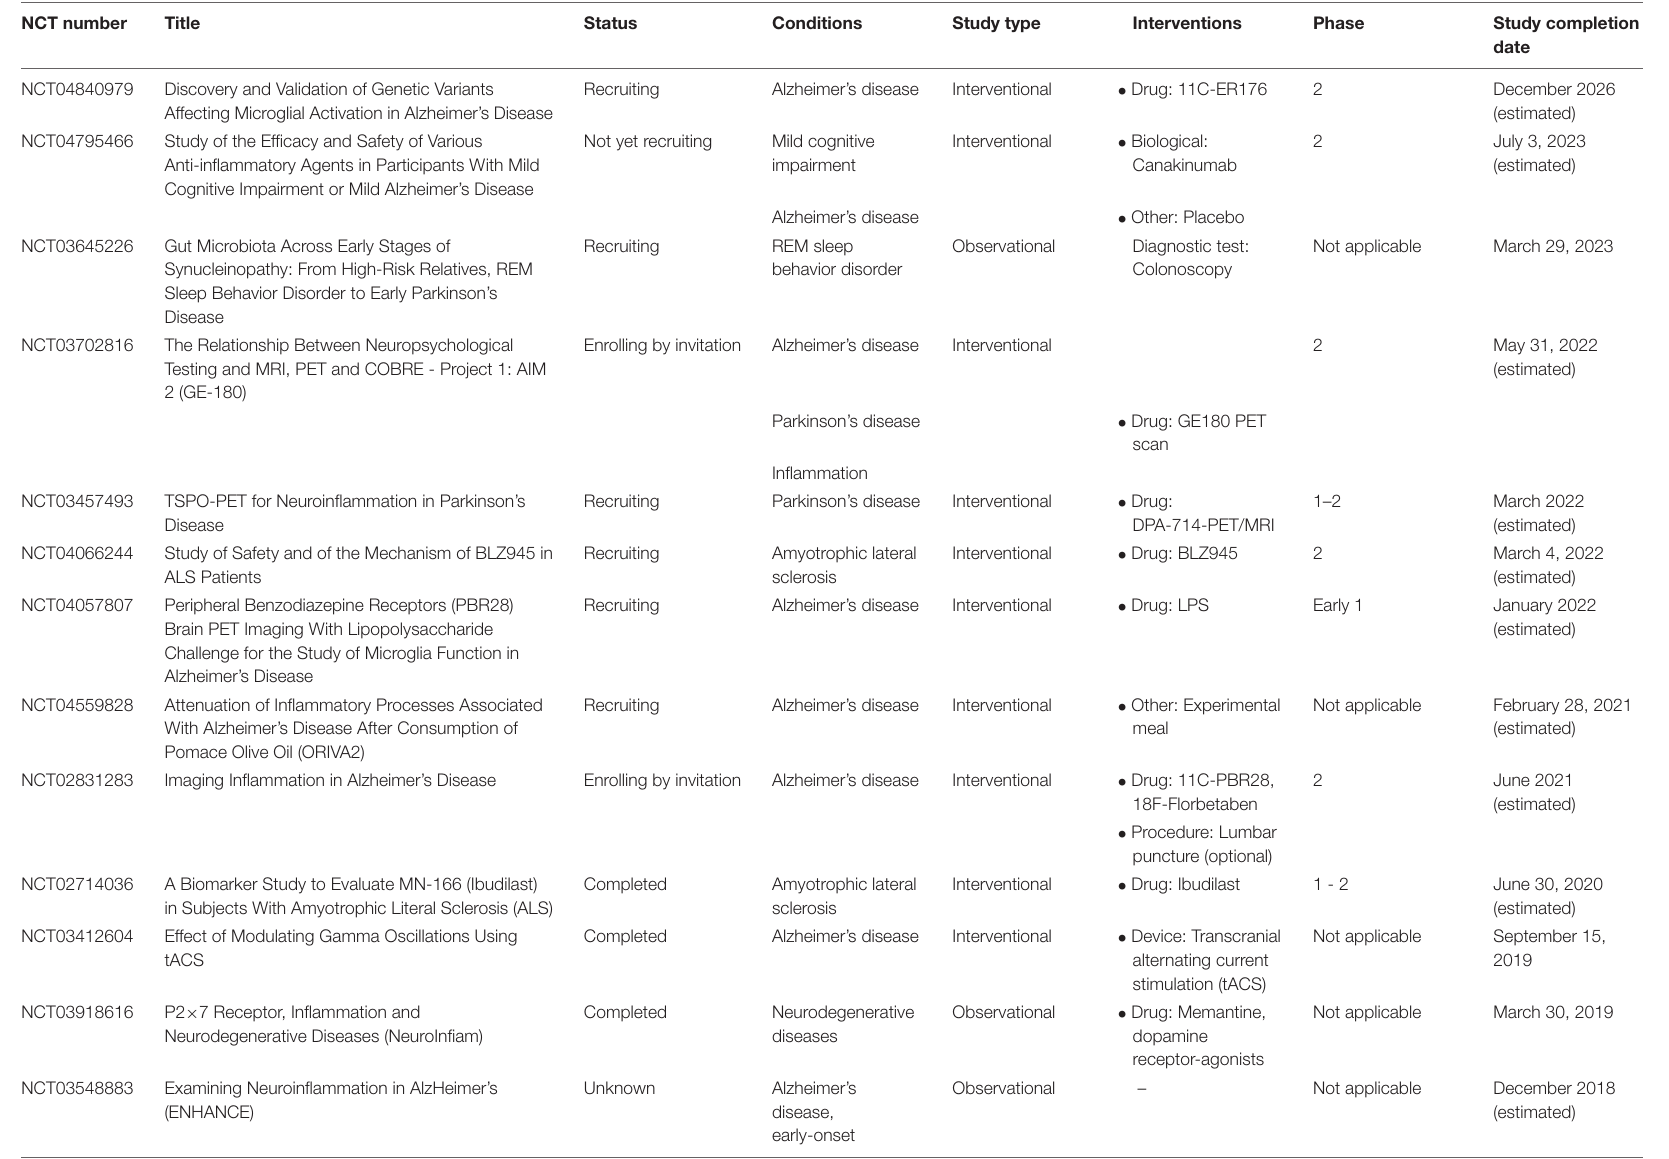
TABLE 2 | Registered clinical trials on https://clinicaltrials.gov focused on microglia and Alzheimer disease , Parkinson disease , and amyotrophic lateral sclerosis